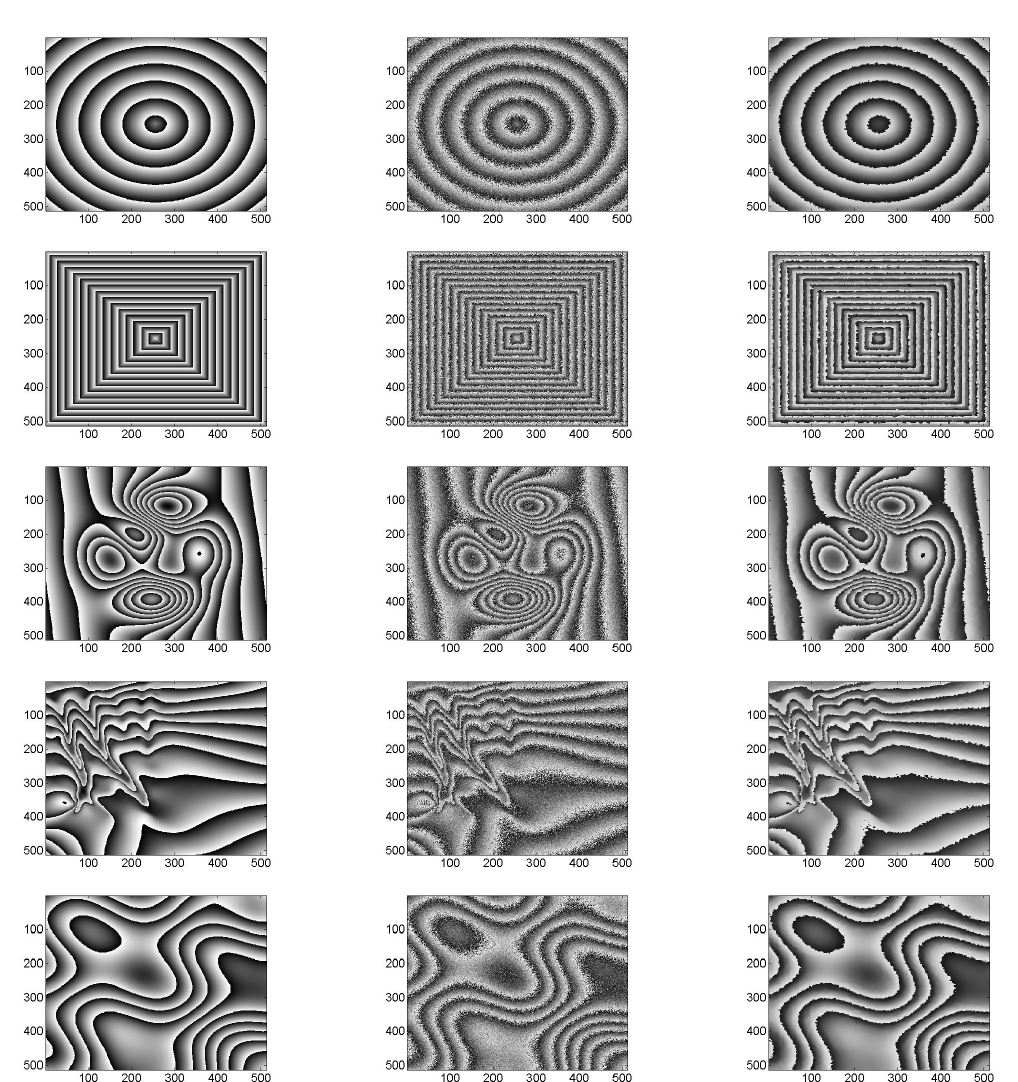
Figure 2: Simulated interferograms filtering results. From top to bottom: cone, pyramid, Gaussian variation, first meshgrid function and second meshgrid function. From left to right: the original interferograms without noise, the corresponding noisy interferograms with σ 2 = 0 . 8 and the filtered results with the proposed